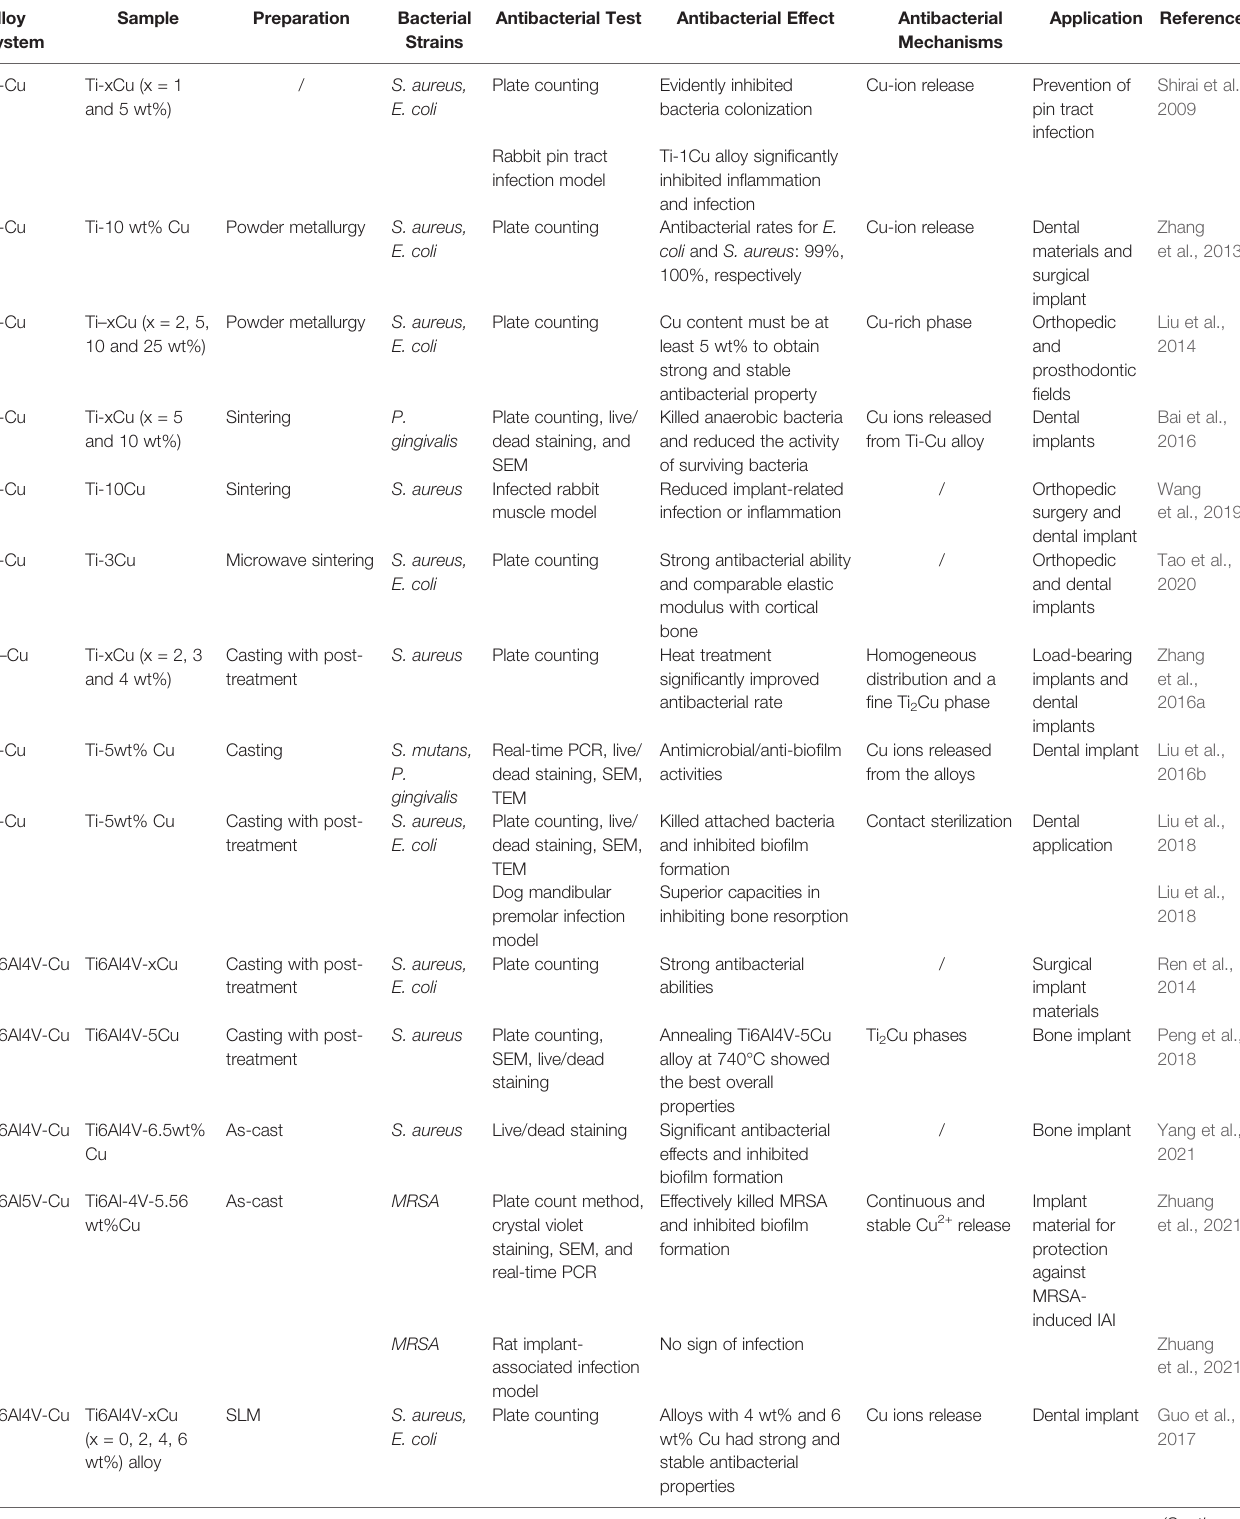
TABLE 1 | Engineered titanium alloys with antibacterial